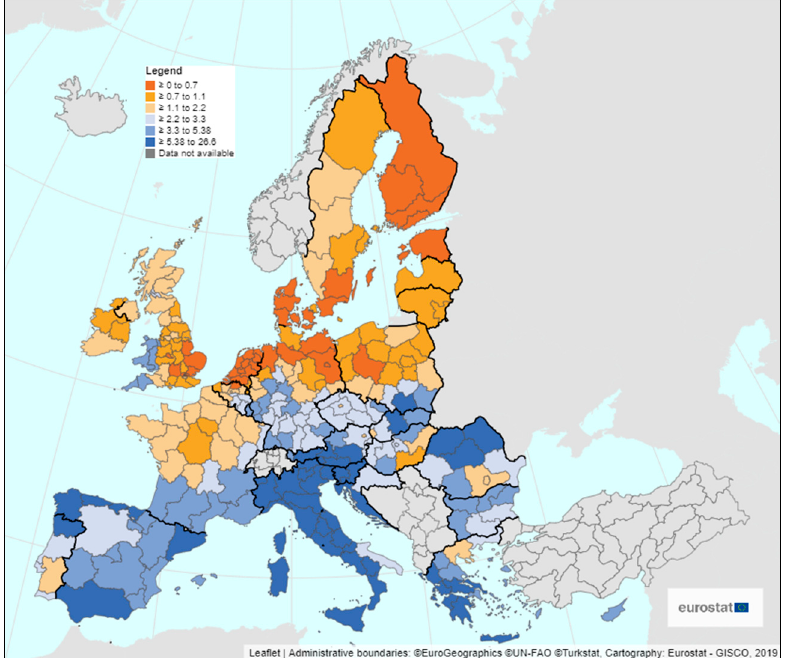
Figure 8. Estimated rates of runoff-induced soil losses (t/ha per year) within agricultural areas at the European Union by the NUTS 2 regions (as of 2016) [53].